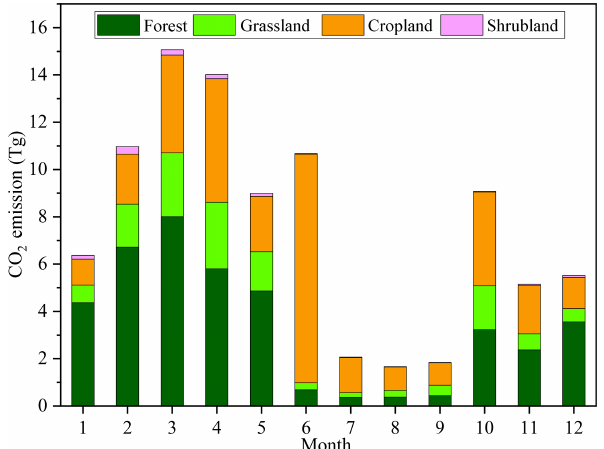
Figure 4. Monthly distributions of source-specific CO 2 emissions (Tg) in